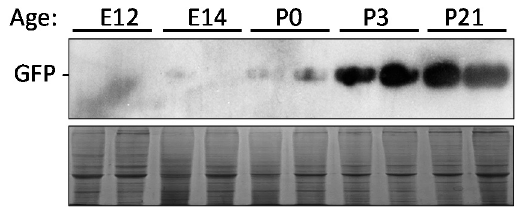
Figure 5. Western blot analysis of different developmental time points of transgenic Japanese quail.